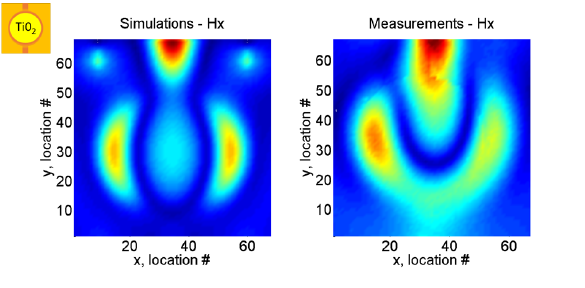
Figure 13: | H x | magnitude of the magnetic field for simula- tions (CST (cid:114) , left) and measurements (right) in the vicinity of the ring resonator covered by TiO 2 at f = 2 . 66